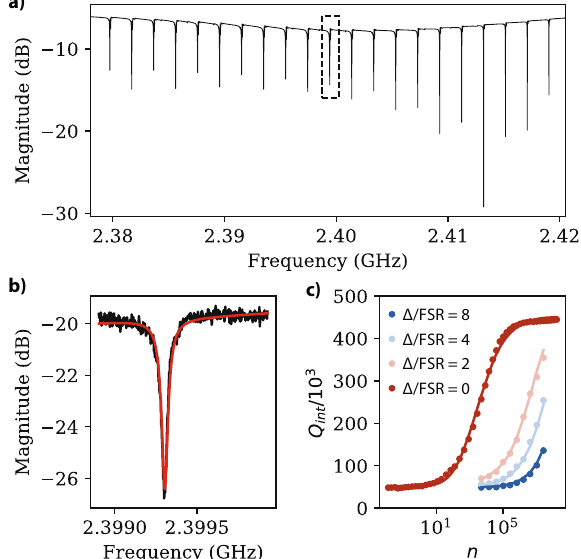
Fig. 1 Resonator characterisation. a Magnitude of the re fl ection coef fi cient of the SAW resonator measured at high power ( n ≈ 4 ⋅ 10 5 ). The dashed outline indicates the pump mode at 2.399 GHz. b Example of fi t to the pump mode resonance at low power ( n < 1). c Internal Q-factor as a function of phonon number in the pump mode for the pump mode (red dots) as well as three probe modes below the pump. The pump-probe detunings are indicated and fi ts are shown as solid lines. The single mode loss saturation is fi tted with Eq. (1). The loss saturation in the detuned probe modes is fi tted with Eq.